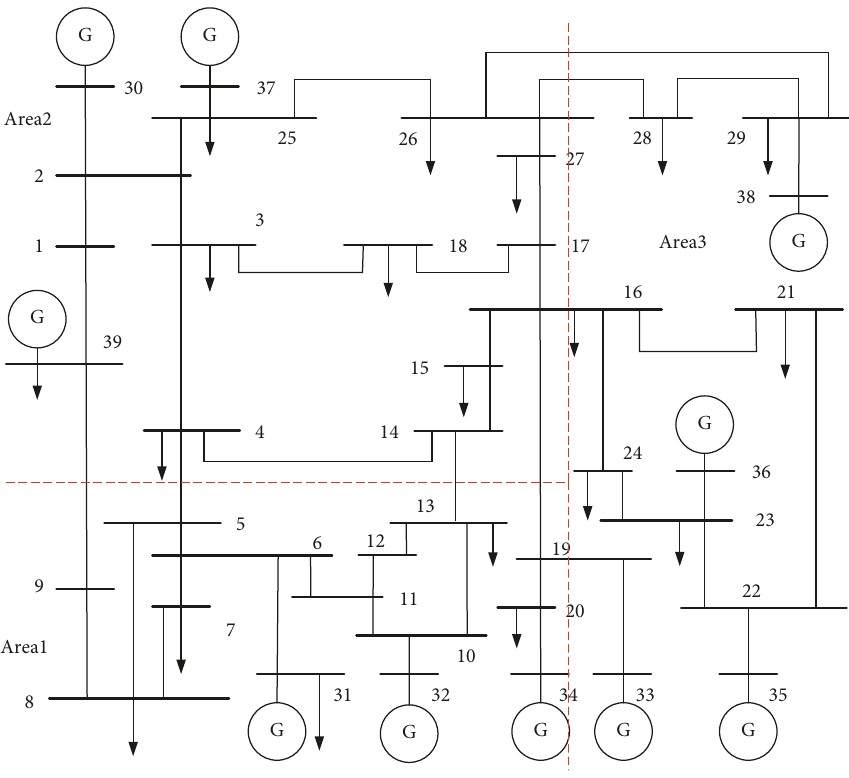
Figure 7: IEEE 39-bus system. Table 2: Simulation parameters of dynamic model of three-area interconnected AGC